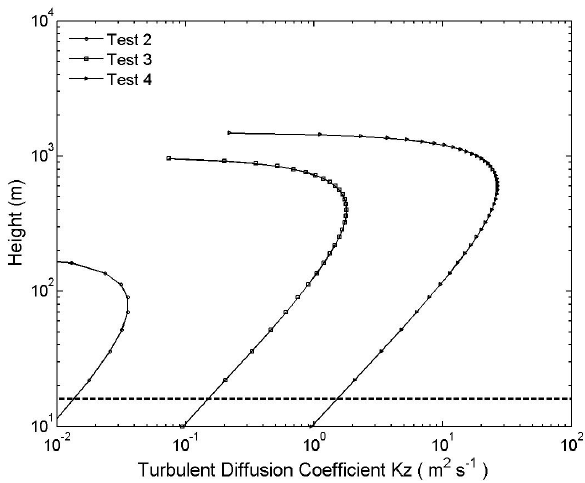
Fig. 1. Vertical profiles of the vertical diffusion coefficient K z used for the sensitivity tests in which the boundary-layer height was chosen to be 200, 1000, and 1500m, respectively. The horizontal dashed line marks the 16-m model half level.